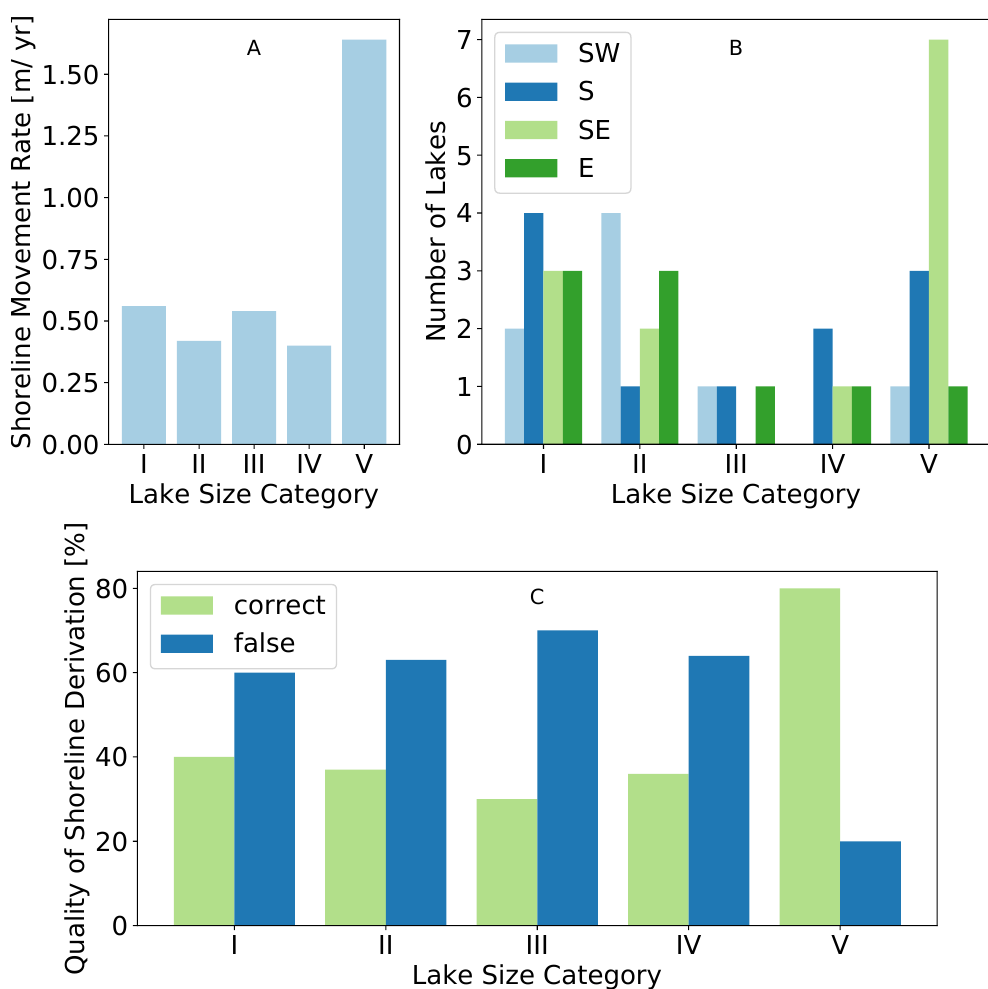
Figure 5. Median annual shoreline movement rate ( A ) and dominant movement directions ( B ) for each lake size category of the sub-sampled dataset at Deadhorse study site. Graph ( C ) shows the quality of the shoreline derivation for each lake